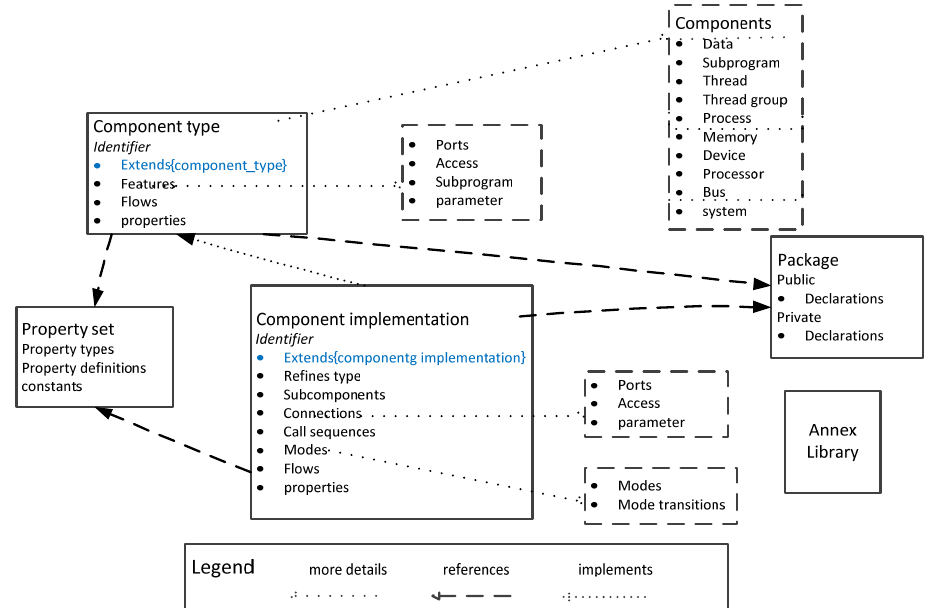
Figure 2. AADL language elements.